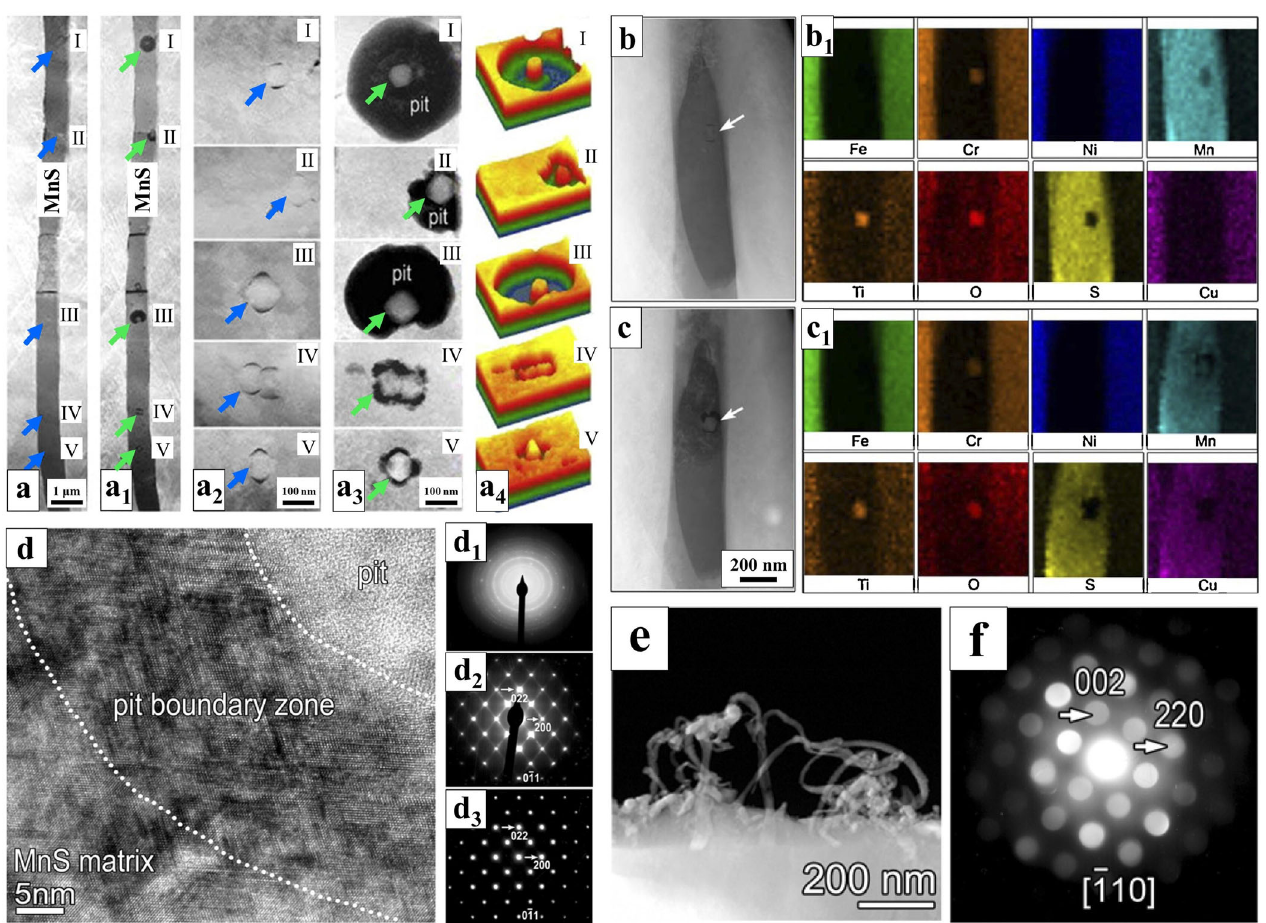
Fig. 7 Corrosion evolution and corresponding characterization of MnS-containing inclusions in aggressive condition. a , a 1 , a 2 , a 3 HAADF images and its partial enlarged views at various locations showing: a , a 1 An MnS inclusion section in stainless steel, where different positions containing MnS inclusions a , a 2 before and a 1 , a 3 after exposure in 1 M NaCl solution for 45 min are labeled with I, II, III, IV, and V, and marked with blue and green arrows, respectively. a 4 Three-dimensional reconstruction morphology of each domain after corrosion. Morphology and elemental distribution results of MnS inclusions in stainless steel alloyed with Cu element b , b 1 before and c , c 1 after immersion in 1 M NaCl solution for 35 min. d A high-resolution TEM images of corroded sites containing MnS inclusions and d 1 , d 2 , d 3 electron diffraction patterns taken in the d 1 dissolution pit, d 2 at the pit boundary and d 3 the region far away from the pit, respectively, after immersion in 1 M NaCl solution for 35 min, e a zoom-in image of the produced Cu 2 S nanowires around the pit and f a NBED pattern taken along the [ − 1 1 0] direction of Cu 2 S 66,80